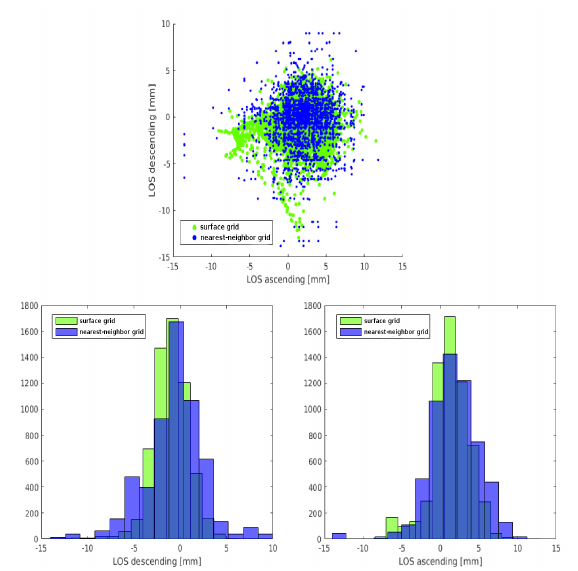
Figure 3. The top image shows a scatter distribution between the nearest-neighbor and the surface merging result while the bottom images show the histogram both for the ascending and the descending data. The sample of scatters was captured on the bottom part of Ciloto District. The sample PS points are located in a stable urban area near to the Ciloto district (ca. 9 km2 area’s size).